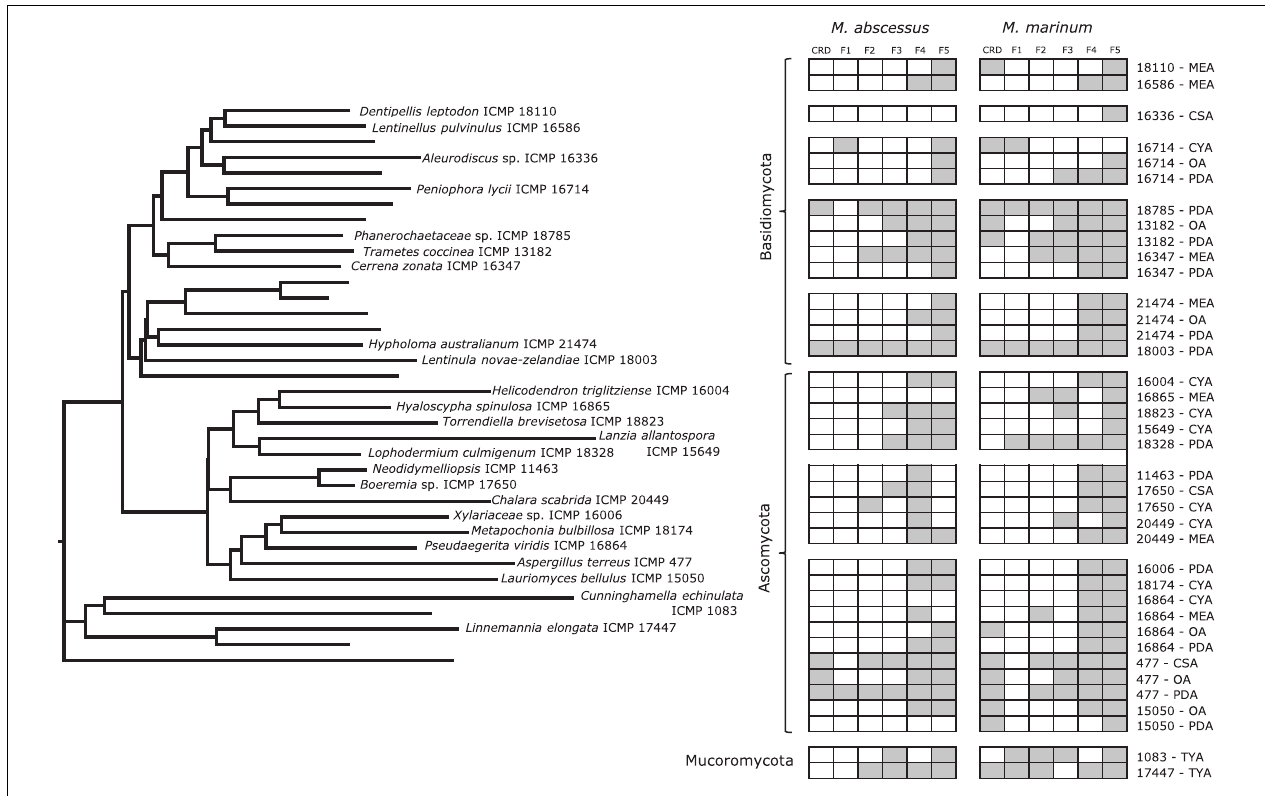
FIGURE 5 | Phylogeny and activity of crude extracts and fractions from ICMP isolates grown in different media against M. abscessus BSG301 and M. marinum BSG101. Active extracts and fractions for each isolate are shown in gray. CSA, Czapek Solution Agar; CYA, Czapek Yeast extract Agar; MEA, Malt Extract Agar; MYA, Malt Yeast extract Agar; OA, Oatmeal Agar; PDA, Potato Dextrose Agar; REA, Rice Extract Agar; TYA, Tryptone Yeast extract Agar. ICMP isolates are described as active if they caused a minimum 1-log (90%) reduction in the bioluminescence of the mycobacterial strains. The phylogenetic tree was constructed by comparing ITS sequences to those in GenBank and the phylogenetic tree was constructed using the Molecular Evolutionary Genetics Analysis version 7.0 software (MEGA7) using the neighbor-joining method and p-distance as the substitution model. Each phylogeny was tested using the bootstrap method with 500 replications.